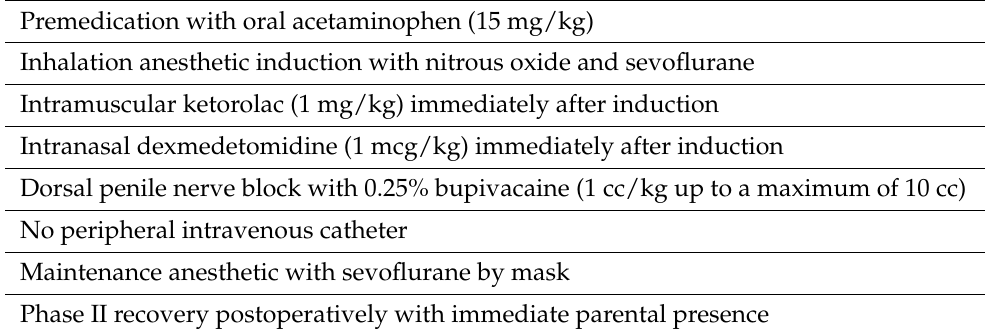
Table 1. Opioid-Free Fast Track